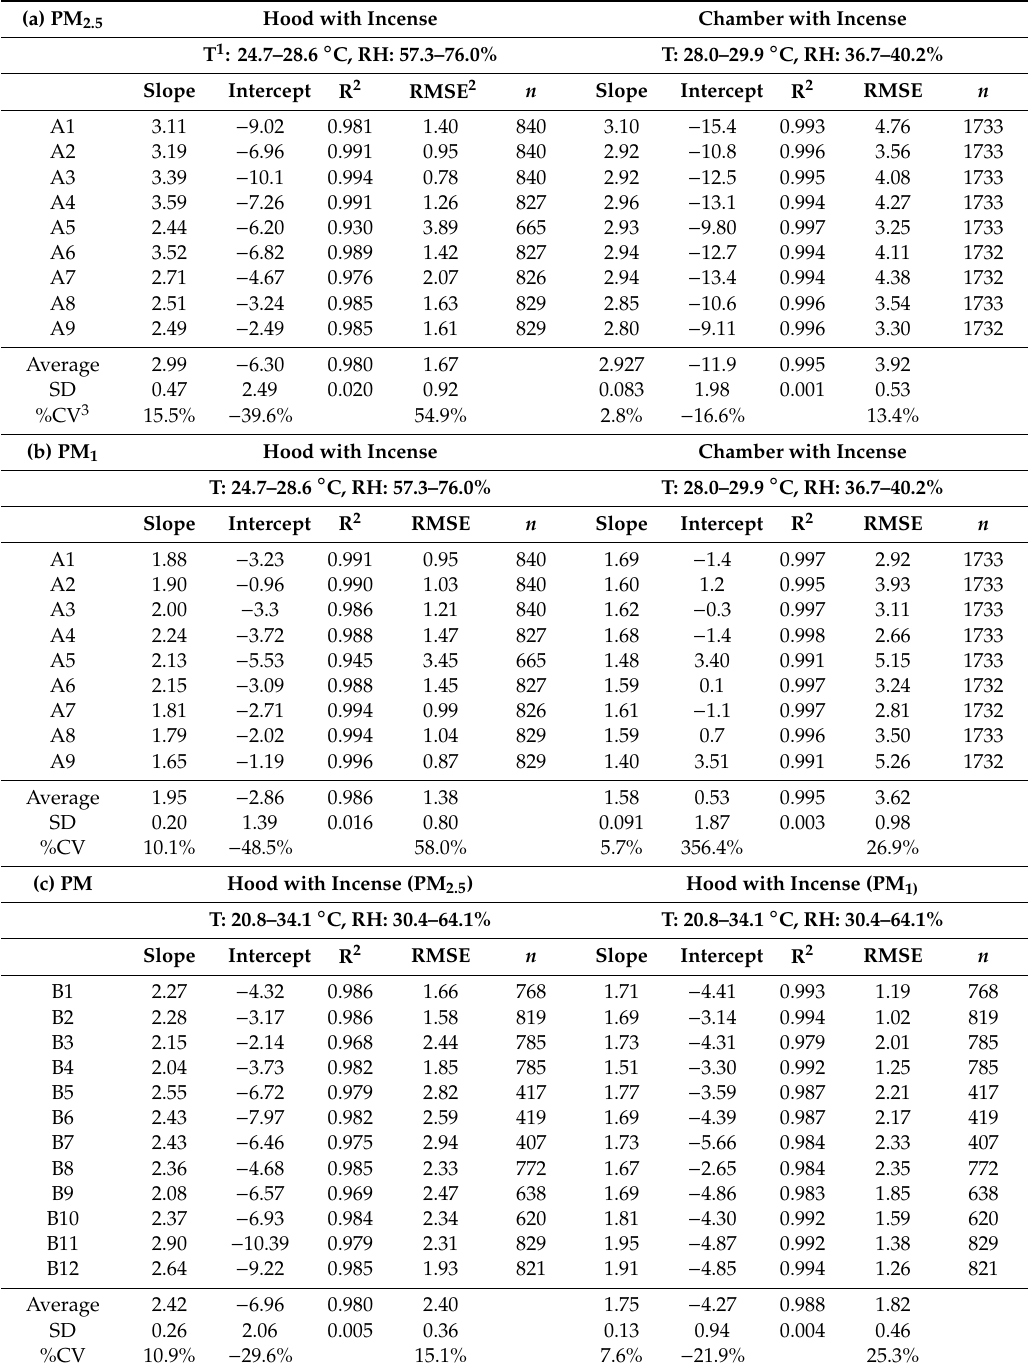
Table 1. Linear correction equations from the hood and chamber experiments with incense for ( a ) PM 2.5 with nine AS-LUNG-P sets, ( b ) PM 1 with 9 AS-LUNG-P sets, and ( c ) PM 2.5 and PM 1 with 12 AS-LUNG-O sets in the range of 0.1–200 µ g / m 3